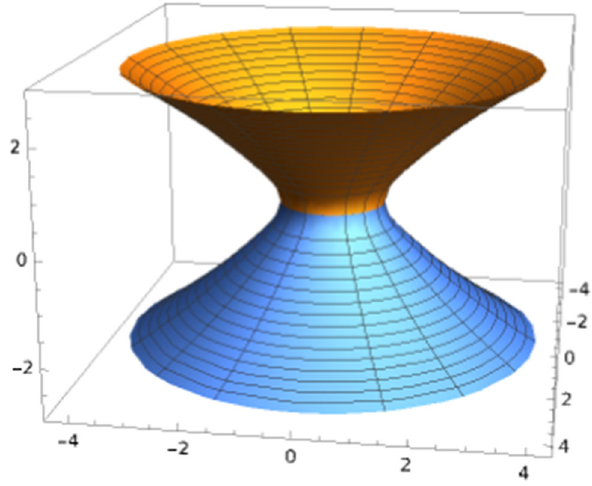
Fig. 1 Embedding diagram of the ER bridge with M = 1, l 0 = 1 and Q = 0